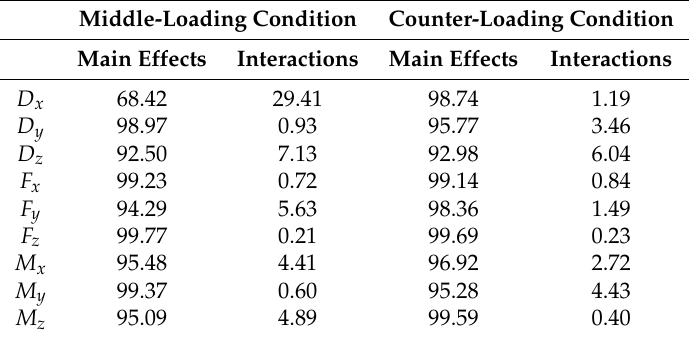
Table 4. Percent contribution of main effects and second-order